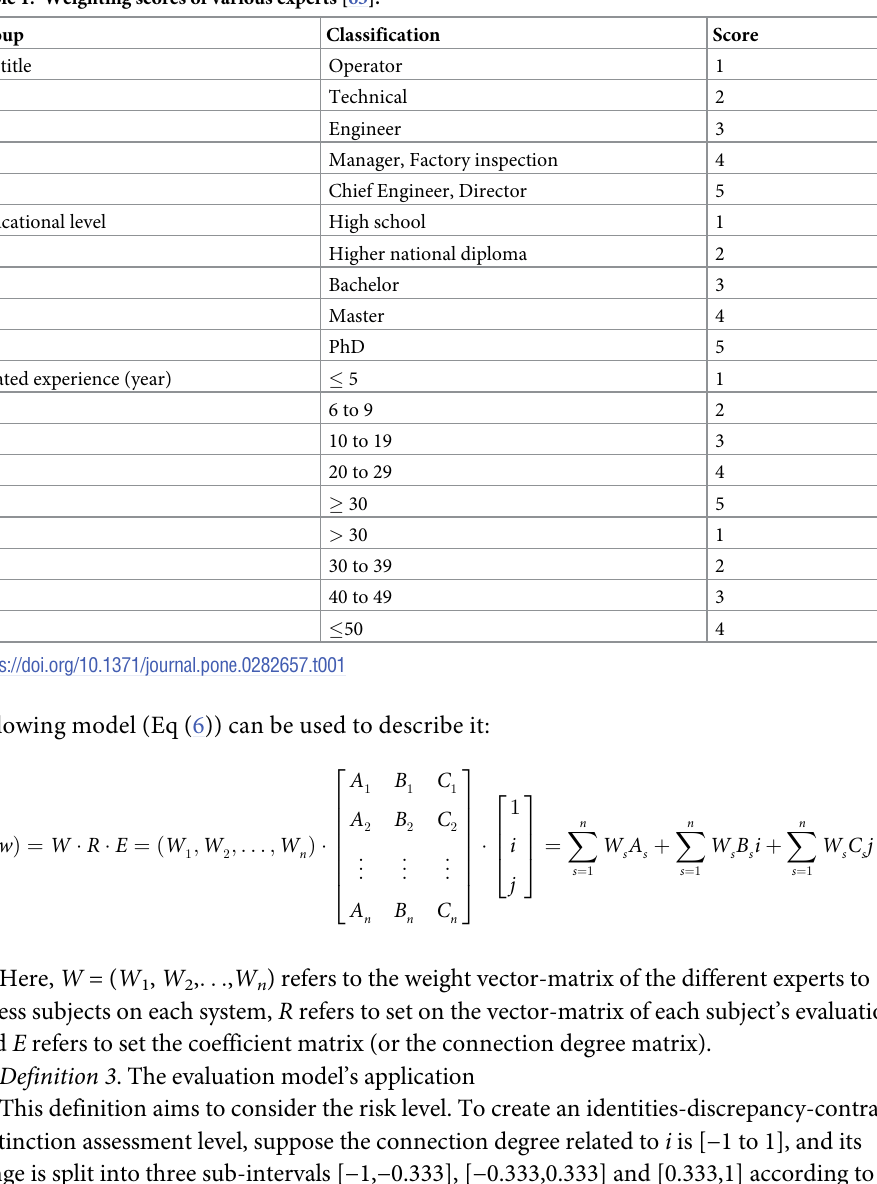
Table 1. Weighting scores of various experts